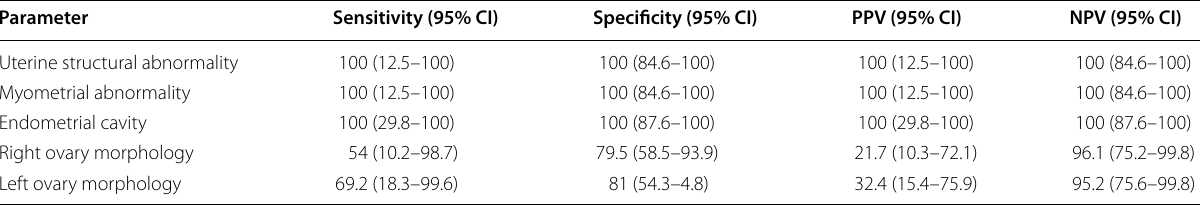
Table 4 Diagnostic accuracy of MR HSG as compared to laparoscopy for non-tubal